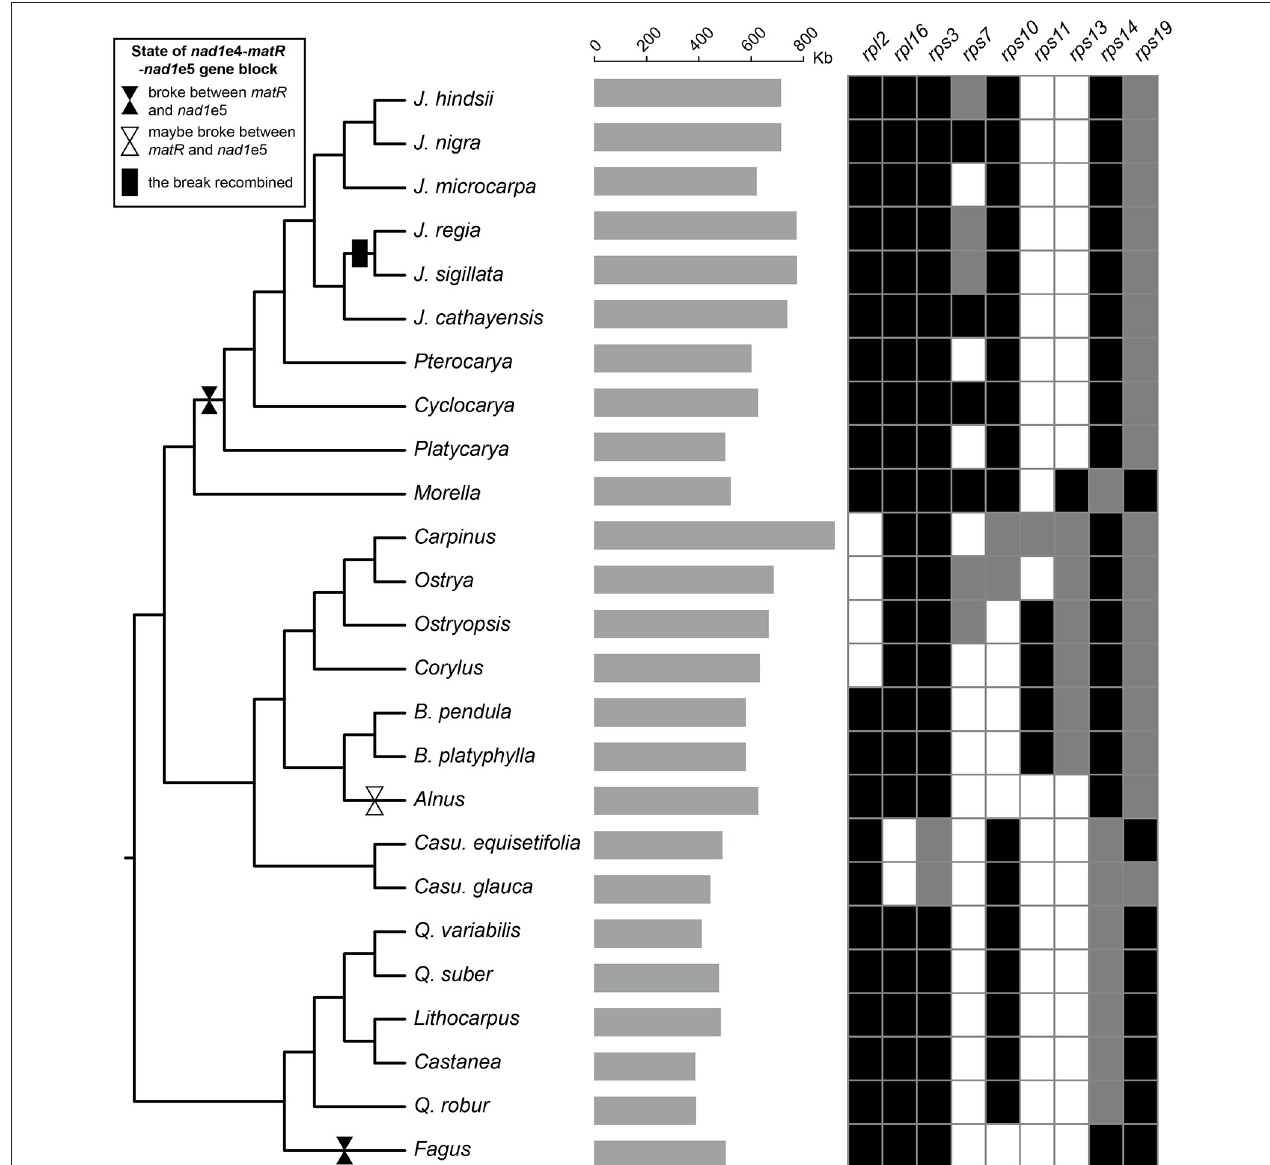
FIGURE 1 | Sampling, mitogenome size, and gene variations. The gray bars in the middle showed the size of the mitogenomes. The grids on the right exhibit gene variations with black, gray, and blank indicating the gene intact, pseudo, and missing, respectively. The plastid tree was used to exhibit the species relationship. The breaks and reunion of the nad1 e4- matR - nad1 e5 block are marked on the branches.